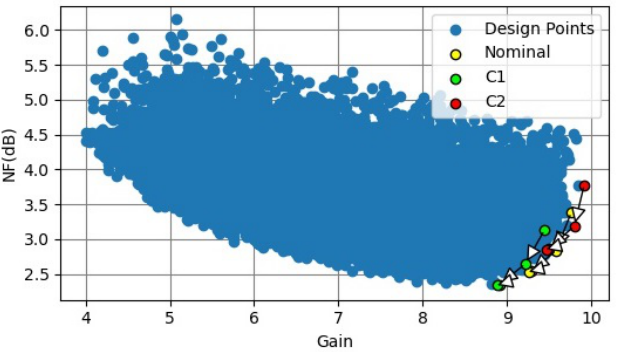
Figure 6. NF vs. gain design space and optimal design points for the three corners: TT 27 ◦ C (Nominal), FF − 40 ◦ C (C1), and SS 125 ◦ C